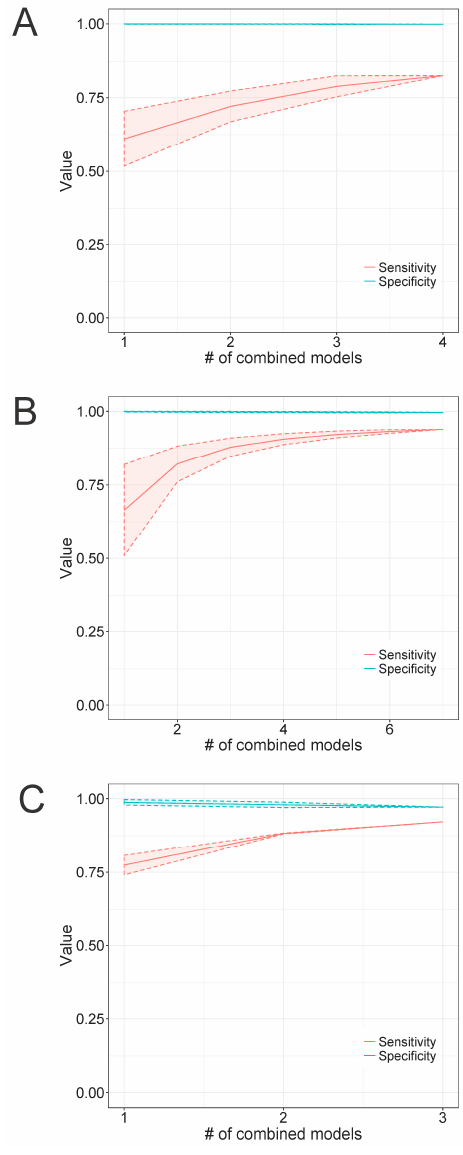
Figure 5. The effect of combining multiple profile HMMs on the ability to detect and discriminate Microviridae sequences. TABAJARA was executed in discrimination mode using a training set composed of 113 Microviridae VP1 sequences. Models specific for Alpavirinae ( A ), Gokushovirinae ( B ) and Pichovirinae ( C ) subfamilies were tested in similarity searches using hmmsearch program against a bona fide dataset of 1836 Microviridae VP1 sequences comprising members of three subfamilies of the family. Tests were performed using multiple combinations of an n number of randomly selected models, ranging from one to the total number of models constructed for each subfamily. Sensitivity and specificity lines, using cutoff scores ascribed by TABAJARA, represent arithmetic means calculated from results observed for the multiple combination of models generated for each value of n . Shaded areas indicate standard deviation values.